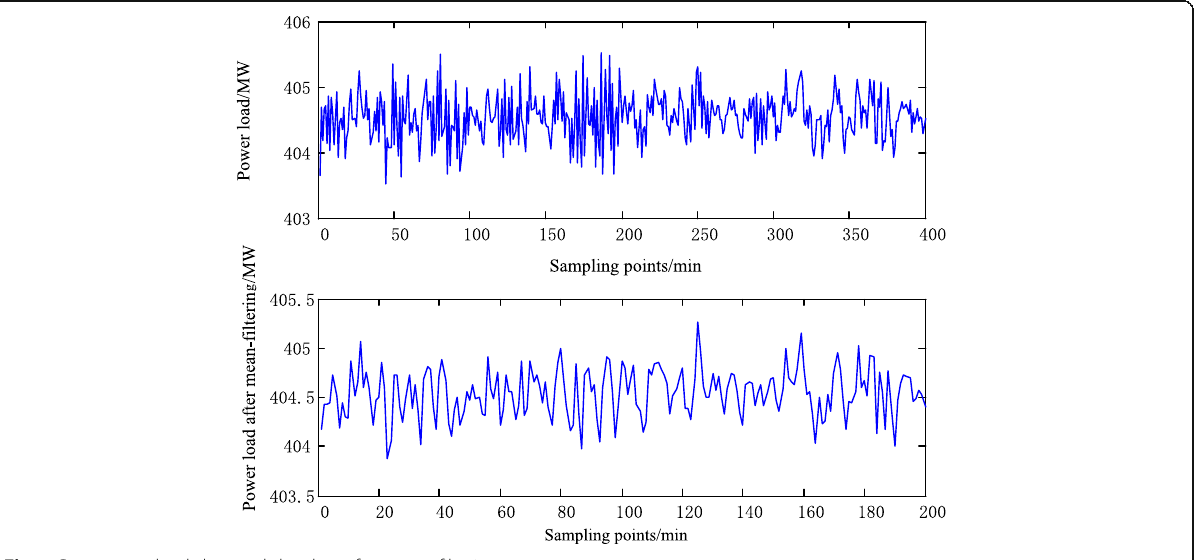
Fig. 1 Raw power load data and the data after mean filtering